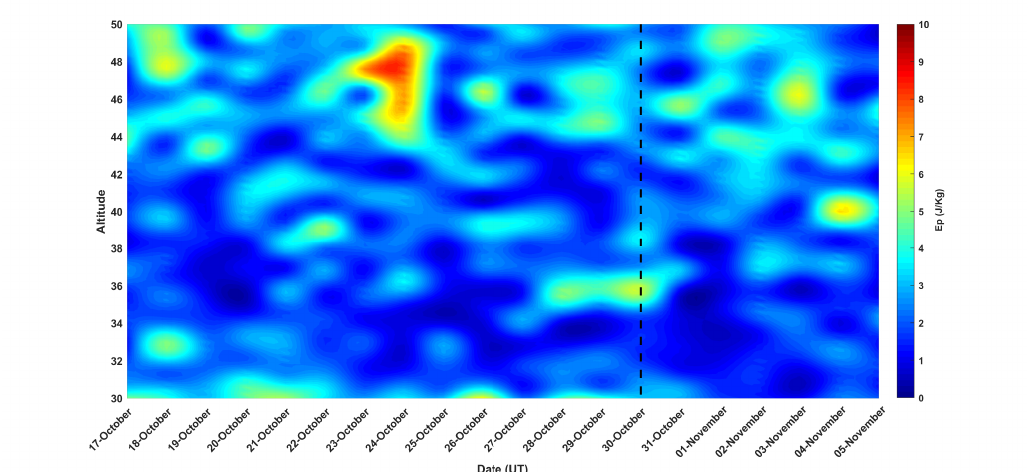
Figure 5. Potential Energy ( E p ) variation associated with with AGW from 17 October to 4 November 2020. Along the x - and y -axis, we present the date and altitude in km, respectively. The colorbar indicates the E p values in J/kg. The black dashed line indicates the EQ